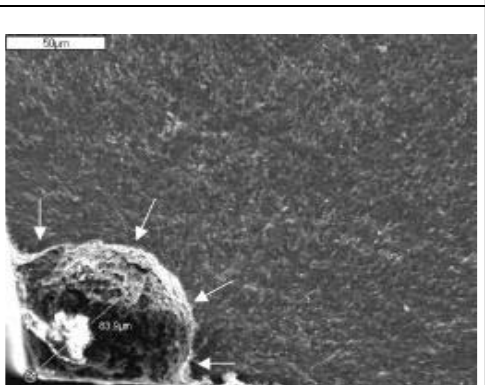
Figure 6 - SEM micrograph of ceramic fracture surface showing a critical flaw (crack) located at the corner of the specimen (outlined by white arrows). Fracture surface of a leucite-based ceramic (IPS Empress, Ivoclar AG, Schaan, Liechstenstein); line from flaw corner, c+84 µm (500x). From Della Bona, et al. 20 , 2004.